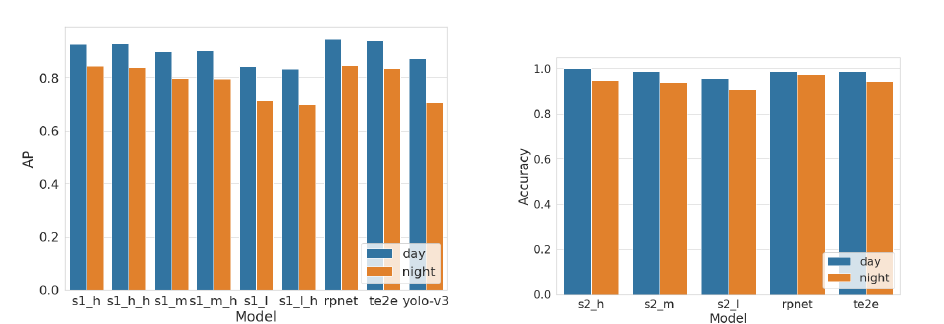
Figure 10. Model accuracy on the synthetically generated dataset ( left ): detection, ( right ) recognition. In the detection stage, the hardware-optimized models have lesser latency than their corresponding hardware-agnostic models (s1_h, s1_m and s1_l). Overall, the low model sizes shown the ability to execute these models in edge devices with low